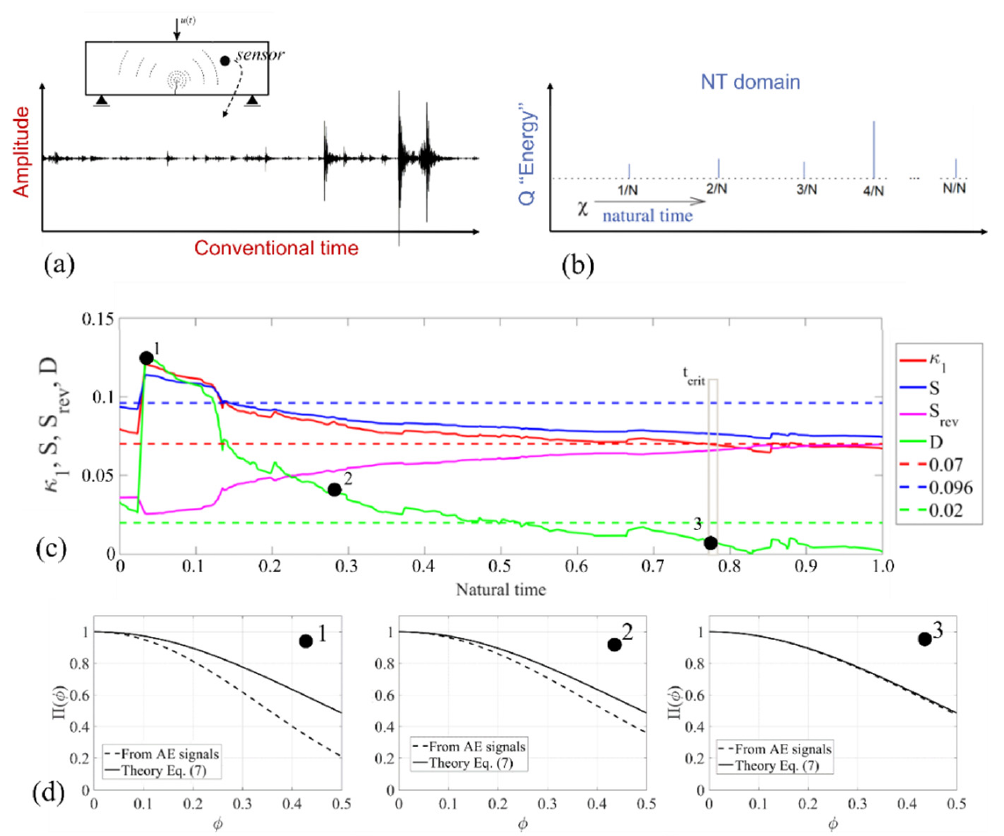
Figure 5. Applying the natural-time method: ( a ) a typical time series from AE signals; ( b ) series description in the natural time domain; ( c ) evolution of the order parameters and entropies in natural time. t crit indicates the point of convergence of the criteria, where the structure enters a critical stage; ( d ) evolution of the normalized power spectrum until reaching t crit .